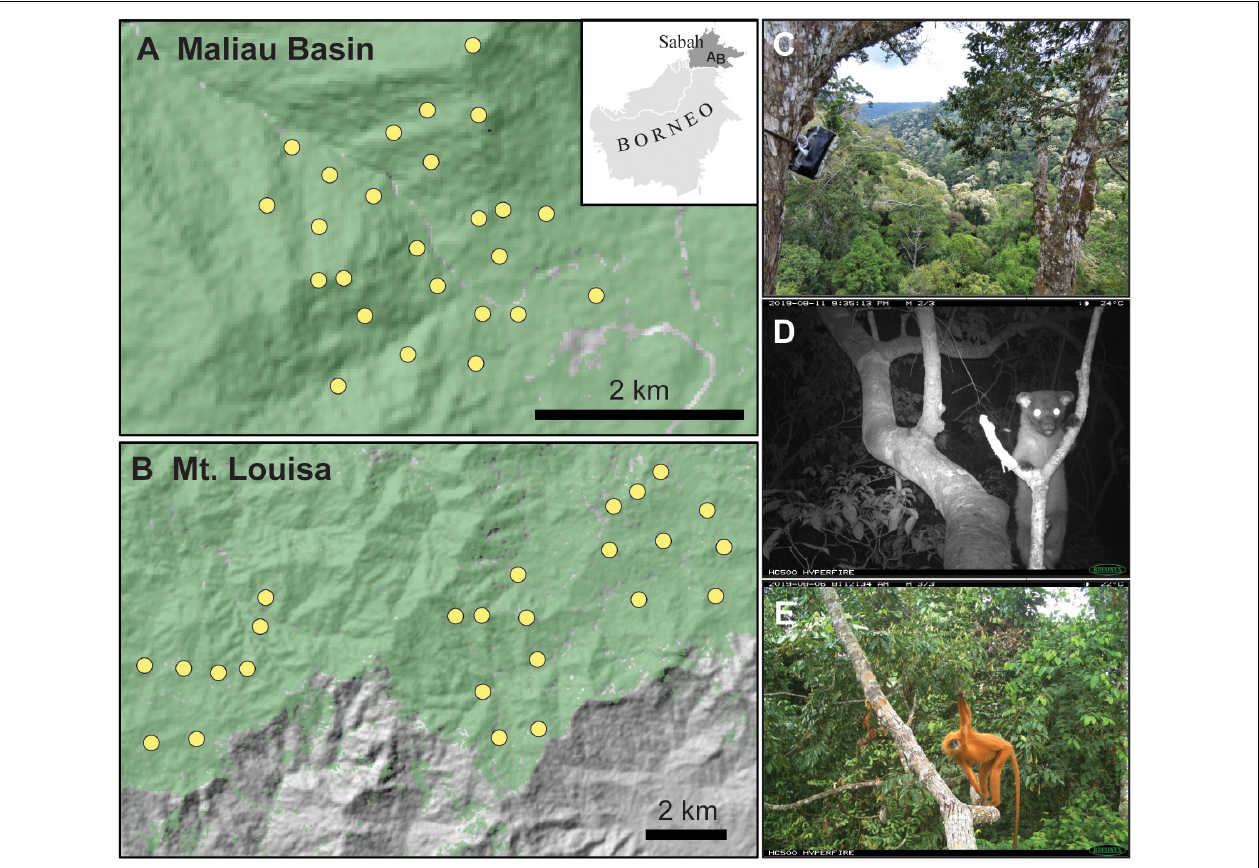
FIGURE 1 | Camera-trap locations in unlogged (A) and logged (B) forest of Sabah, Borneo, with the location of the sampling in relation to Borneo shown on the inset maps. Canopy camera-traps were set on the trunk of trees, facing focal branches (C) . Example arboreal species detected included small-toothed palm civet Arctogalidia trivirgata (D) and maroon langur Presbytis rubicunda (E)